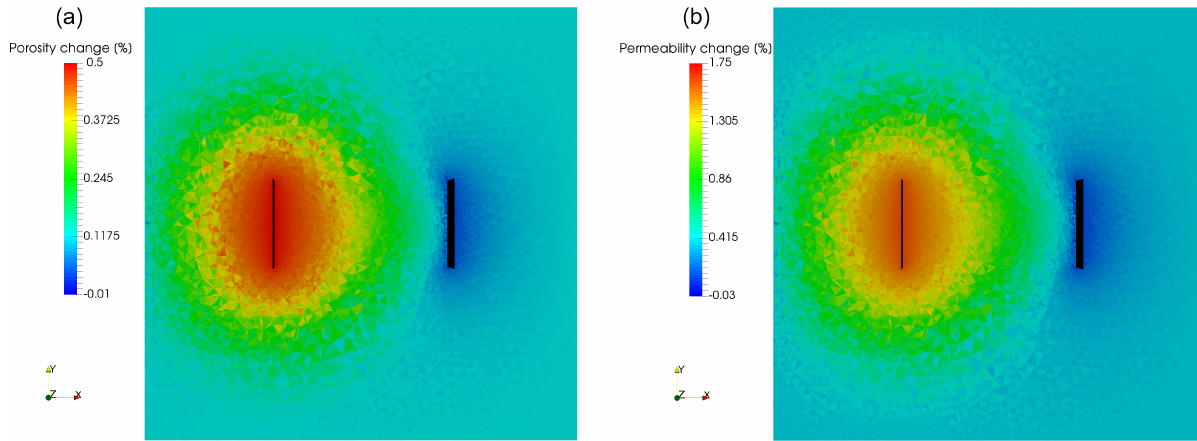
Figure 11. Horizontal slices of the model illustrating the changes in transport properties. Panel (a) shows the distribution of the changes in porosity and panel (b) the changes in permeability after 50 years of